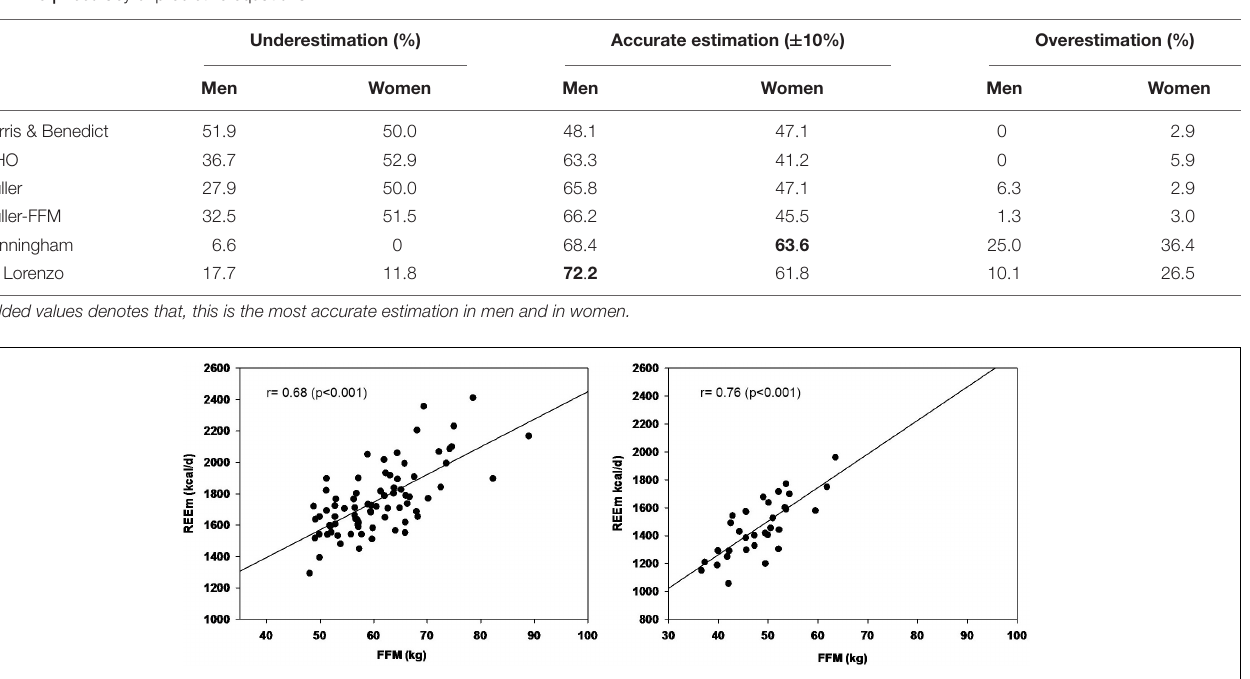
Frontiers in Physiology |